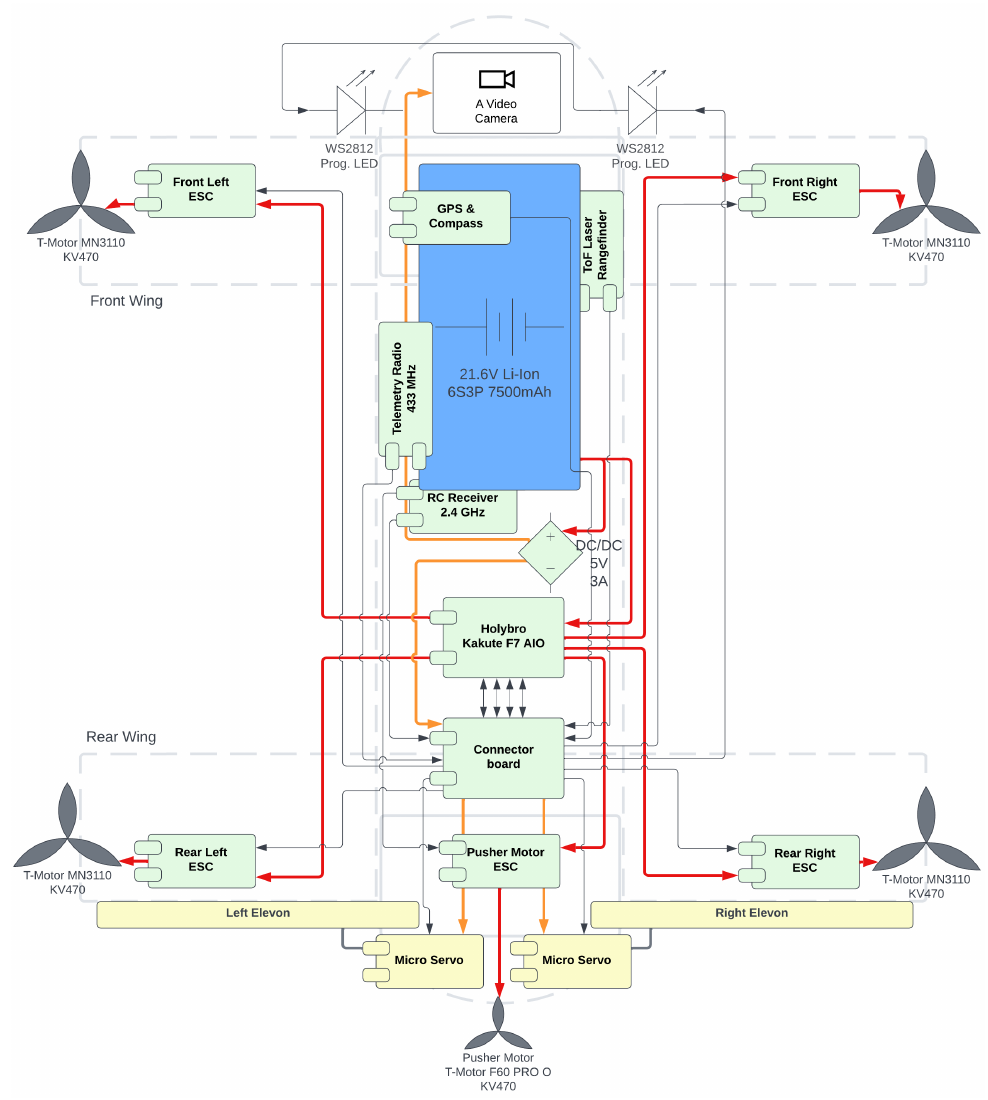
Figure 18. A diagram explaining the wiring of all electronic components of the Elka1Q drone. We used good-quality 18 AWG power wires with XT60 and XT30 connectors. For the signal connectors, we used Ninigi NXG-02 [41] (2mm raster connectors), 2–6 pins, depend- ing on a particular component to